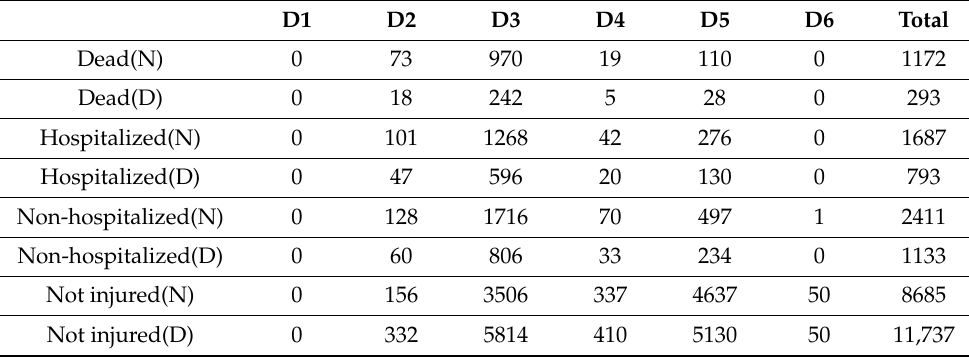
Table 25. Number of casualties in the 1780 earthquake in District 6 of Tabriz.